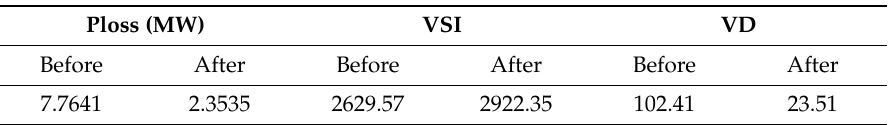
Table 6. Optimization results at the base case and after installation of renewable DGs and capacitor banks in the distribution